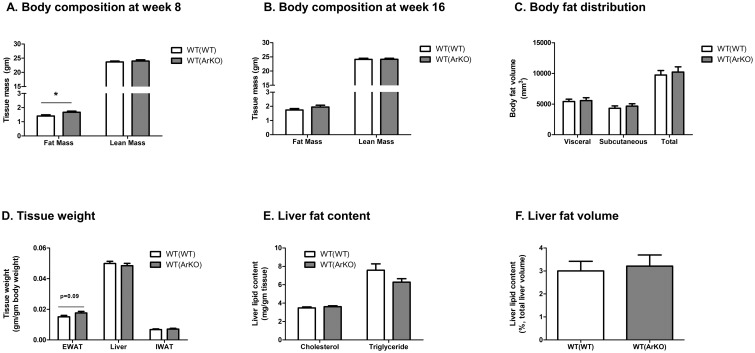
Body composition in wild-type (WT) male mice transplanted with bone marrow from either WT (WT(WT)) or aromatase-deficient (WT(ArKO) donors.WT(ArKO) mice exhibited greater total body fat mass at week 8 (A) but not week 16 (B). At week 22, fat mass distribution was similar between groups (C). At sacrifice, tissue weights were similar between groups, although a trend was found toward greater epididymal fat pad weight in WT(ArKO) mice relative to WT(WT) mice (D). Liver lipid content was comparable between groups whether quantified by cholesterol and triglyceride mass (E) or liver fat volume as measured by MRI (F). *p<0.05.